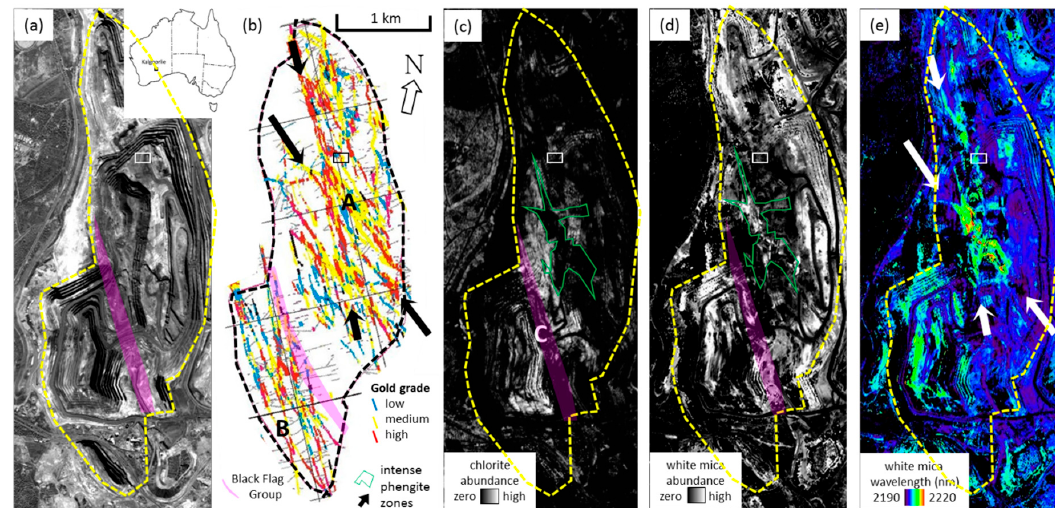
Figure 6. Airborne AMS 1998 mineral mapping results for the Superpit, Kalgoorlie, Western Australia. Approximate position − 30.7715 ◦ latitude 121.5021 ◦ longitude. ( a ) AMS visible albedo image of the Superpit together with an overlay of the Black Flag Group (magenta), which in theory spans the Golden Mile Fault; ( b ) Map of gold grade modelled from blast hole drill analyses for the approximate date of the AMS survey (courtesy of Kalgoorlie Consolidated Gold Mines, Australia. Major linear zones of Au highlighted by black arrows; ( c ) Processed AMS image of the continuum-depth of the 2260 nm absorption (~chlorite content). Green polygon of long wavelength 2200 nm feature ( e ) shown for cross-reference; ( d ) Processed AMS image of the continuum-depth of the 2200 nm absorption (includes white mica). Green polygon of long wavelength 2200 nm feature ( e ) shown for cross-reference. ( e ) Processed AMS image of the wavelength minimum of the continuum-removed 2200 nm absorption (~white mica Tschermak substitution but kaolin has not been masked/unmixed). Examples of major linear zones of phengite are highlighted by white arrows.